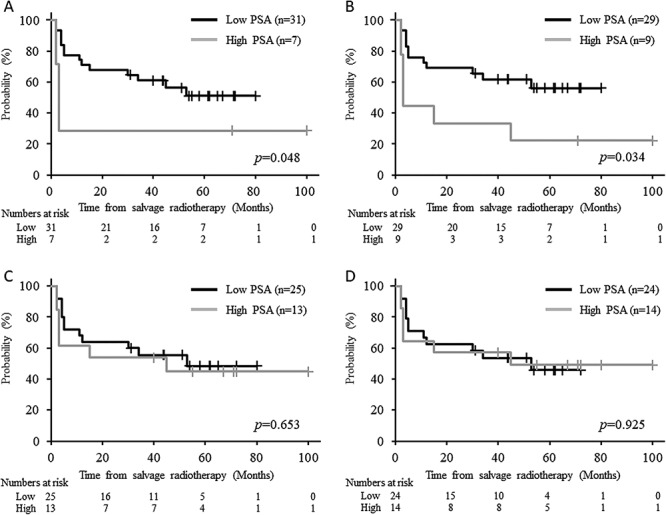
Kaplan–Meier curves for biochemical recurrence-free survival according to different cutoff prostate-specific antigen (PSA) levels before hypofractionated salvage radiotherapy. Cutoff PSA levels: 0.5 ng/ml (A), 0.45 ng/ml (B), 0.35 ng/ml (C) and 0.30 ng/ml (D). No patient had a PSA level of 0.35–0.45 ng/ml.